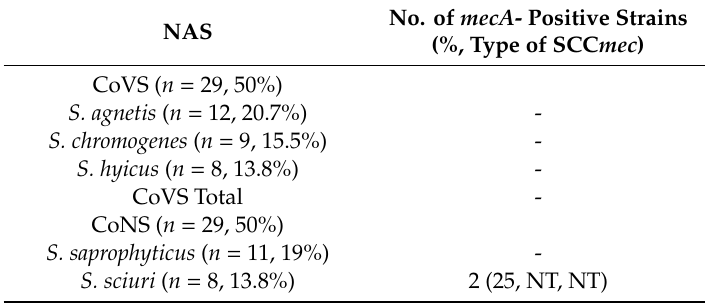
Table 1. Profiles of non- aureus staphylococci (NAS) isolated from retail chicken meat in Korea. No. of mecA - Positive Strains NAS (%, Type of SCC mec ) CoVS ( n = 29, 50%) S. agnetis ( n = 12, 20.7%) - S. chromogenes ( n = 9, 15.5%) - S. hyicus ( n = 8, 13.8%) - CoVS Total - CoNS ( n = 29, 50%) S. saprophyticus ( n = 11, 19%) - S. sciuri ( n = 8, 13.8%) 2 (25, NT,